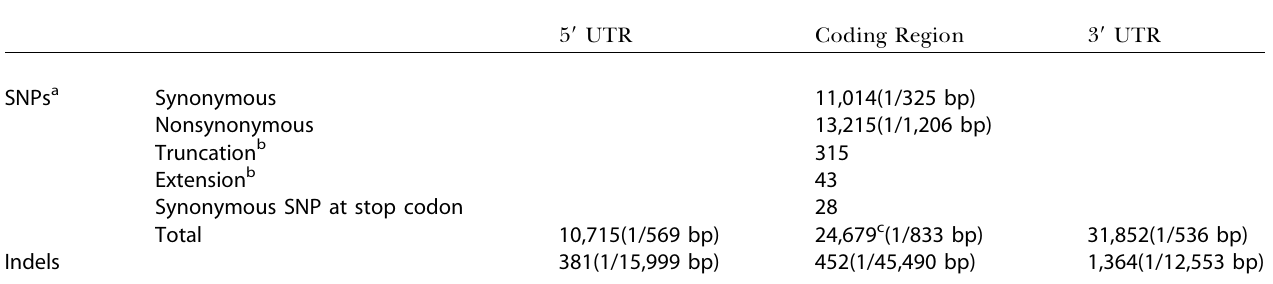
Table 5. The Numbers of SNPs and indels Occurring in the Representative cDNAs